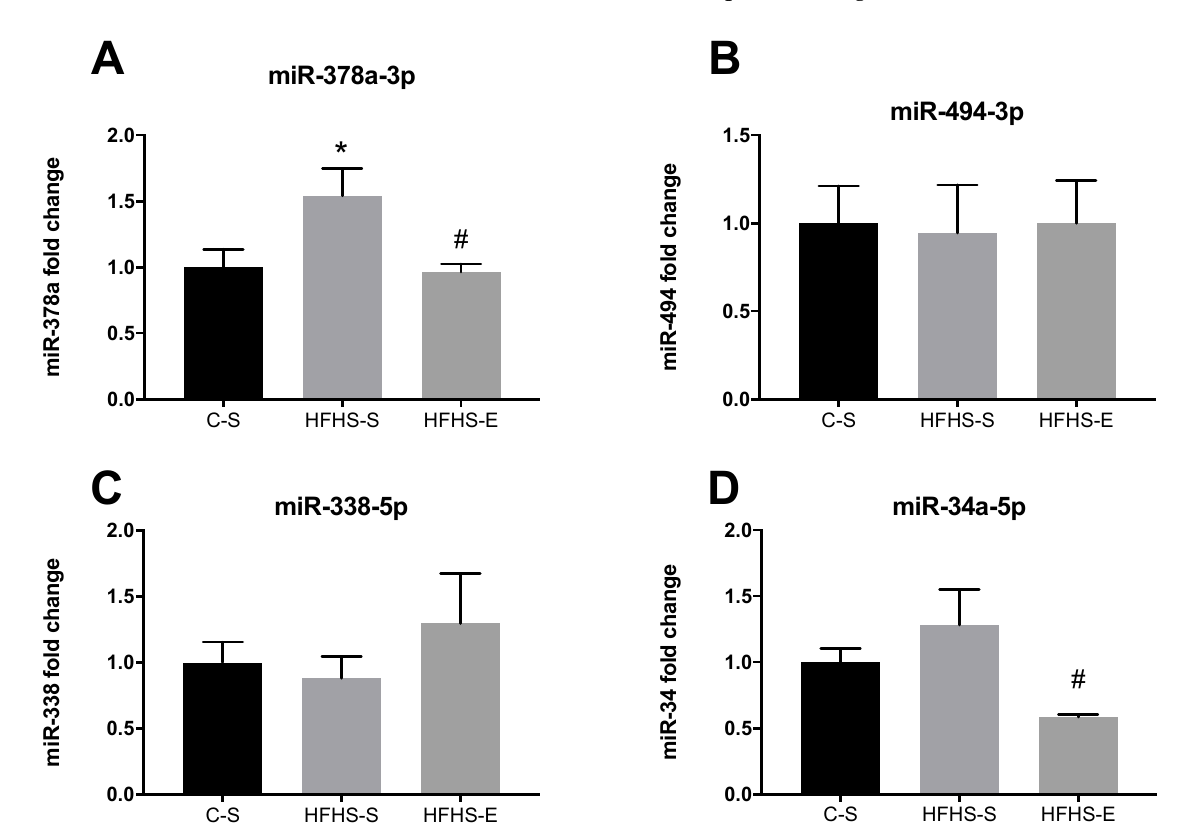
Figure 6. Expression levels of miR-378a-3p ( A ) miR-494-3p ( B ) miR-338-5p ( C ) and miR24a-5P ( D ) in soleus muscle. Offspring from the control diet sedentary group (C–S); offspring from the high-fat, high-sucrose diet sedentary group (HFHS–S); offspring from the high-fat, high-sucrose diet exercised group (HFHS–E), n = 6. Data are expressed as the mean ± SEM. Statistically significant differences ( p ≤ 0.05) are indicated as follows: * vs. C–S, # vs. HFHS–S.